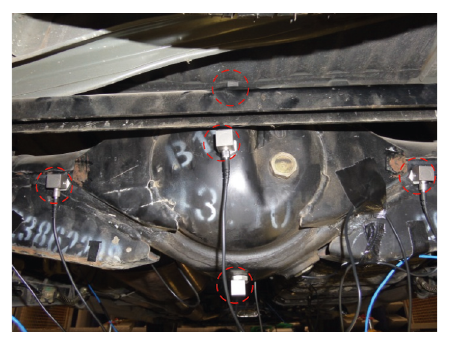
Figure 8: Rear axle ODS test. Table 3: Sensors used in test.